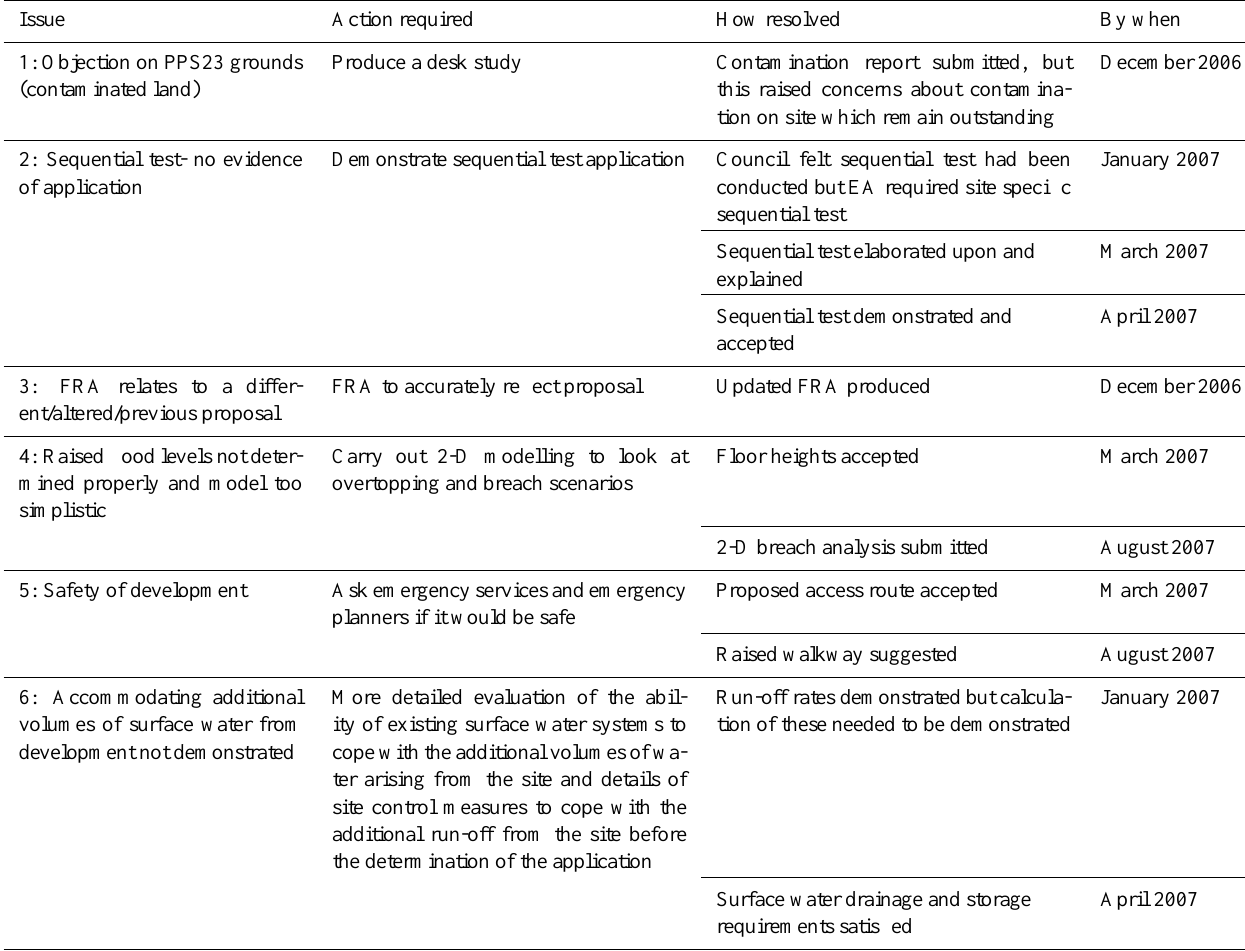
Table 1. “To Do” list set by Environment Agency consultation reply of October